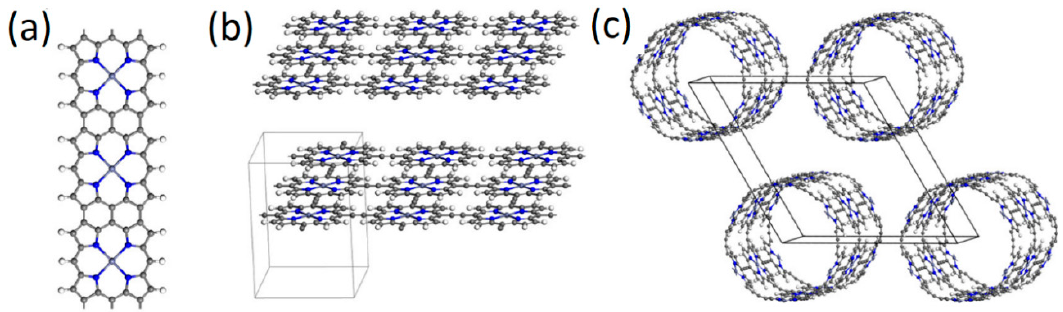
Figure 5. Typical structures of porphyrin ( a ) nanowire, ( b ) nanosheets, and ( c ) nanotubes. Reprinted with permission from reference [61] Copyright 2018 American Chemical Society.